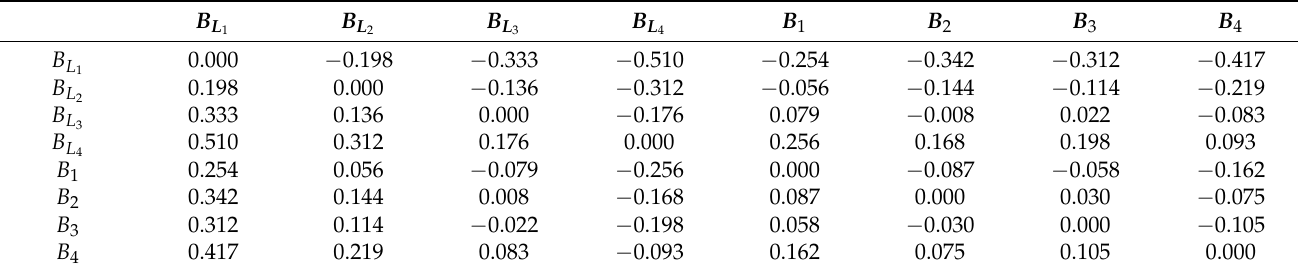
Table 9. Net preference intensity.